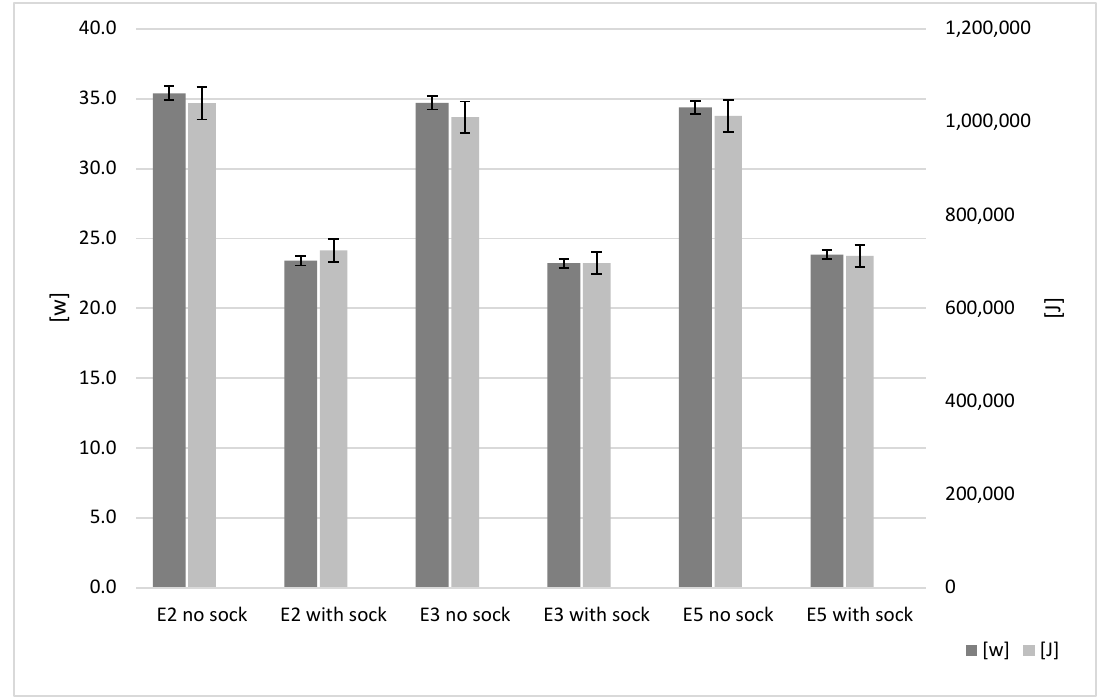
Figure 4. Hot ‐ end influence on energy results. Figure 4. Hot-end influence on energy